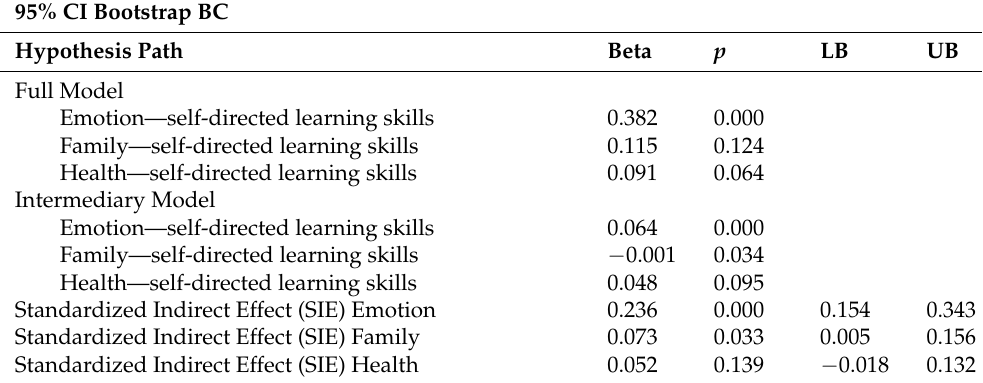
Table 3. Personal factors’ indirect effects on self-directed learning, with goal acquisition as a mediator. 95% CI Bootstrap